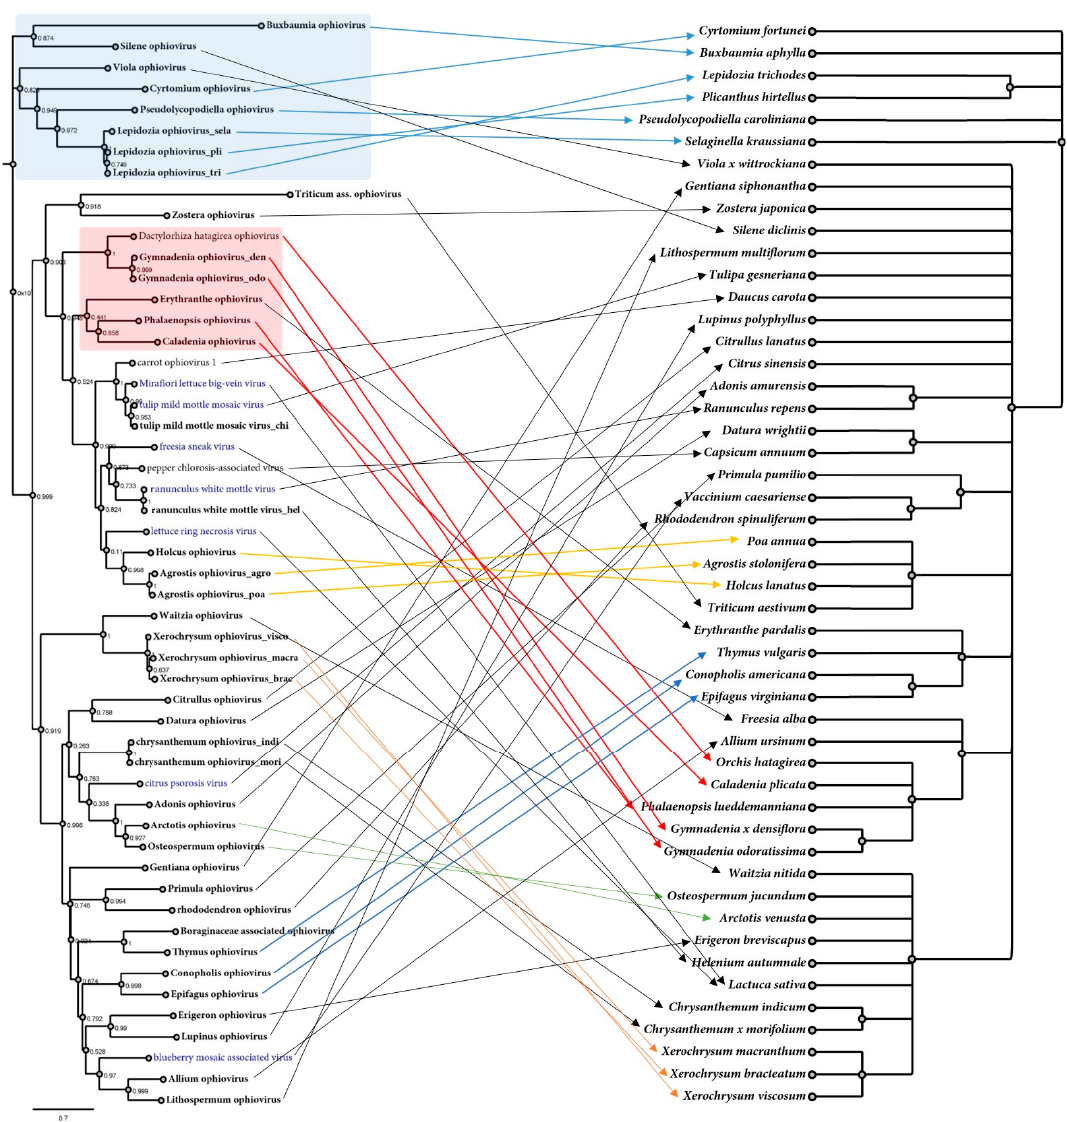
Figure 2. Maximum-likelihood phylogenetic tree based on the amino acid MAFFT sequence align- ments of the CP protein of all the ophioviruses reported thus far and in this study. The scale bar indicates the number of substitutions per site. The node labels indicate FastTree support values. The CP proteins of two cytorhabdoviruses (alfalfa dwarf virus YP_009177015 and lettuce necrotic yellows virus YP_425087) were used as outgroups. Viruses corresponding to members of ICTV- recognized species are depicted in blue.